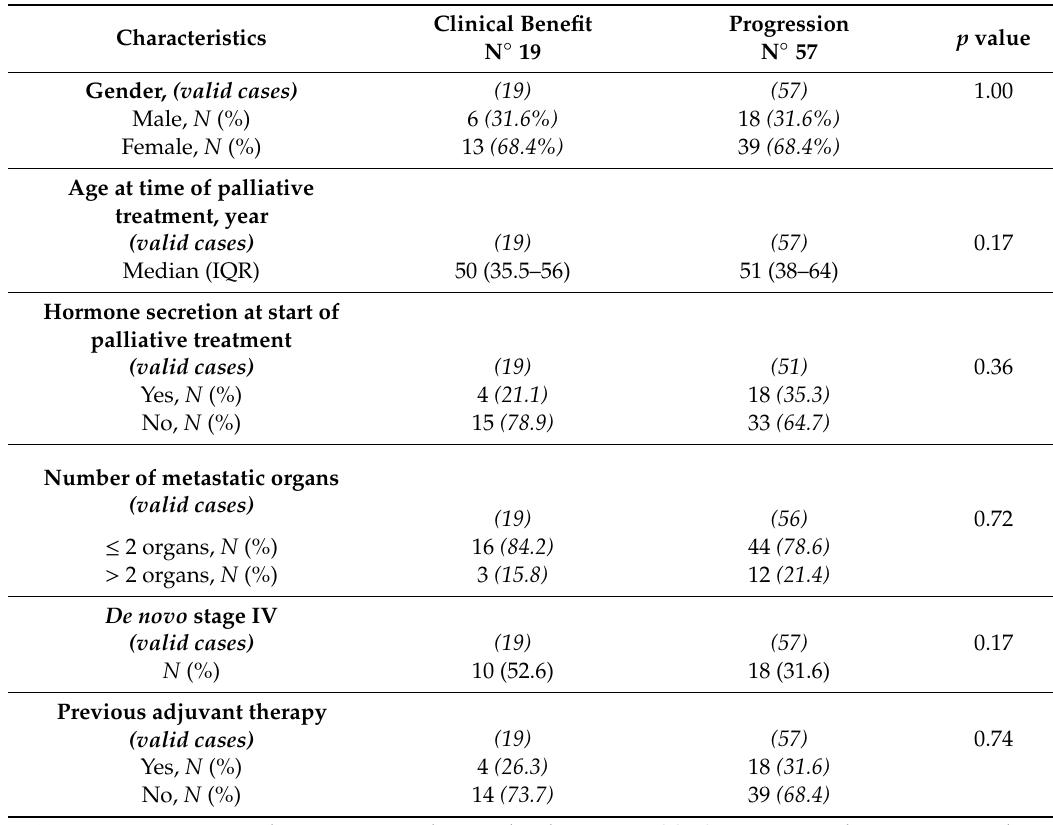
Table 4. Comparison between patients who had clinical benefit vs. patients who progressed at the first line of treatment.